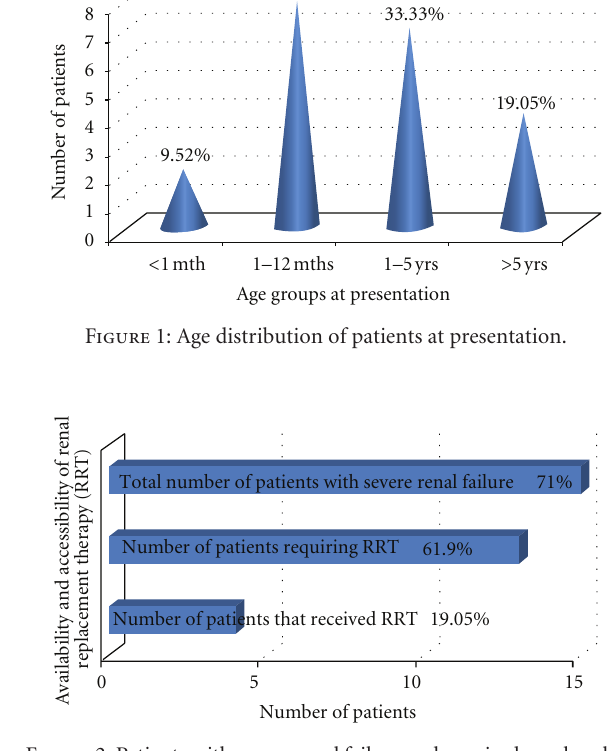
Figure 2: Patients with severe renal failure and required renal repla- cement therapy (RRT) at